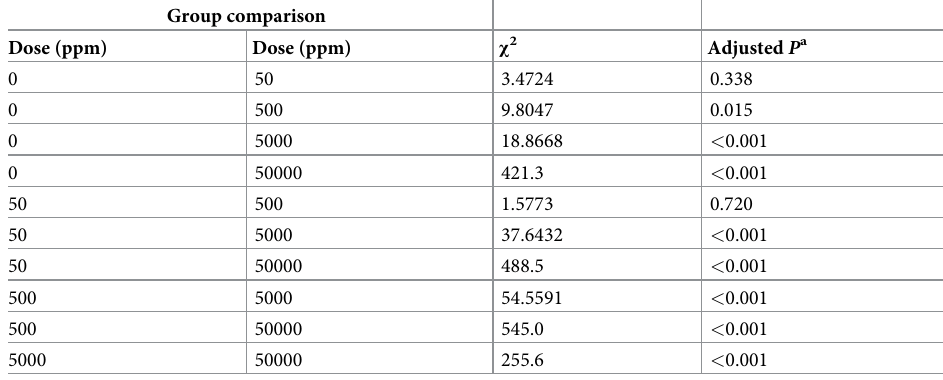
a P -values from pair-wise comparisons were adjusted for multiplicity using the SIMULATE option of the LIFETEST procedure of SAS